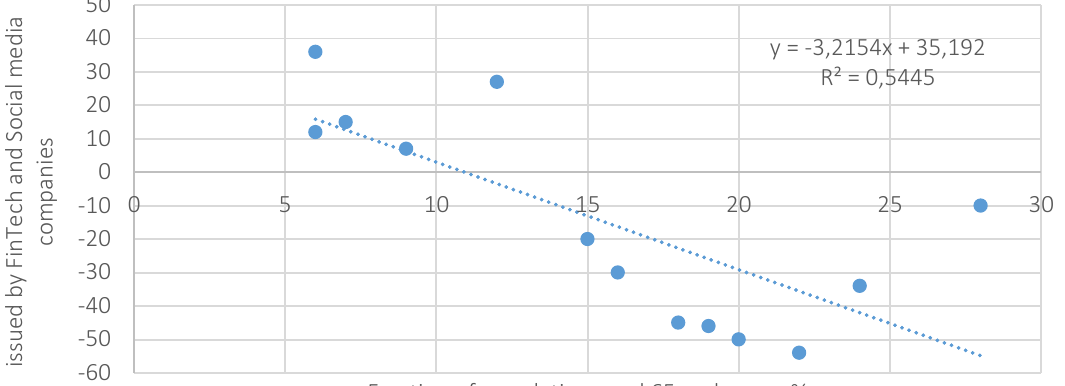
y = -3,2154x + 35,192 R² = 0,5445